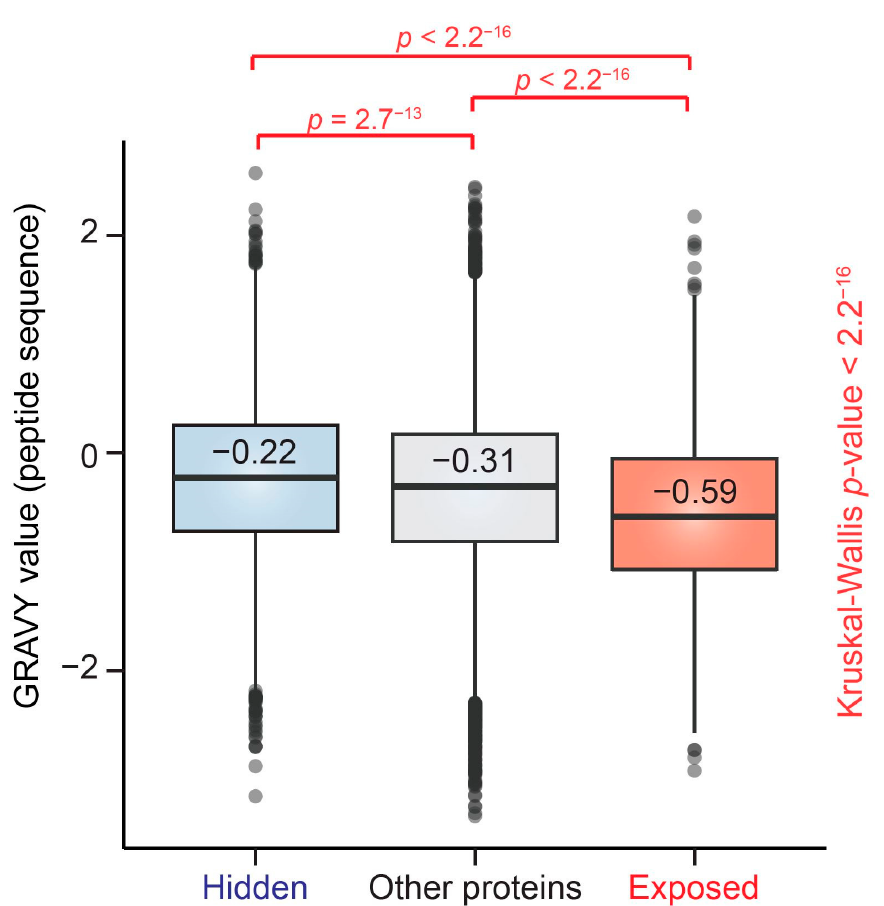
Figure 4. Hydropathy index distribution of peptides corresponding to ‘exposed’ and ‘hidden’ protein groups. GRAVY value distributions of identified peptides corresponding to ‘exposed’ proteins, ‘hidden’ proteins, and the remaining proteins from the data set (‘Other proteins’) are shown. The difference between these groups was evaluated using Kruskal–Wallis test. Pairwise comparisons were performed using pairwise Wilcoxon test with Bonferroni correction. The hydropathy values range from − 2 to +2 for most proteins, with the positively rated proteins being more hydrophobic. The bold line and the number above the line indicate median values; box borders represent the 25th and 75th percentiles, and whiskers represent the minimum and maximum value within 1.5 times of interquartile range. Outliers out of this range are depicted using solid dots.